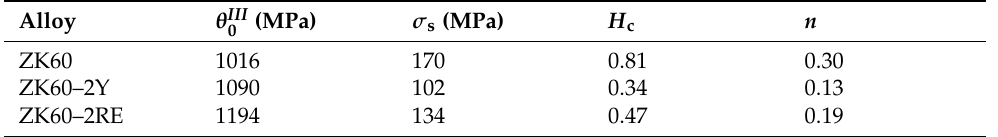
Table 2. Extrapolated WH limit in stage III ( θ III ), corresponding saturation stress ( σ s), hardening 0 capacity (Hc), and work hardening exponent (n) for the three studied alloys. Alloy θ III (MPa) σ s (MPa) H c n 0 ZK60 1016 170 0.81